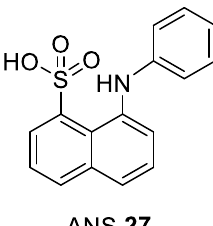
Figure 6. Chemical structure of 8-anilino-1-naphthalene sulfonate (ANS) the most studied type IV CDK inhibitor.